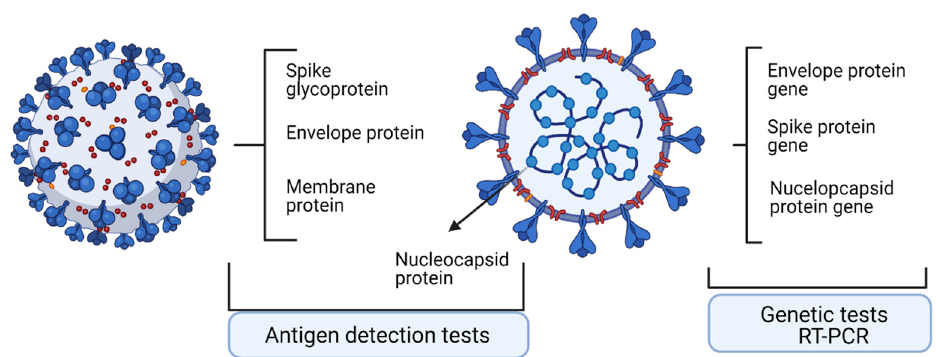
Figure 1. Main molecular targets and antigens detected in SARS-Cov2 infection used in diagnosis. Created with BioRen- der.com. (access on 1 October 2021) Table 1. Main characteristics of molecular and antigen tests in SARS-CoV-2.